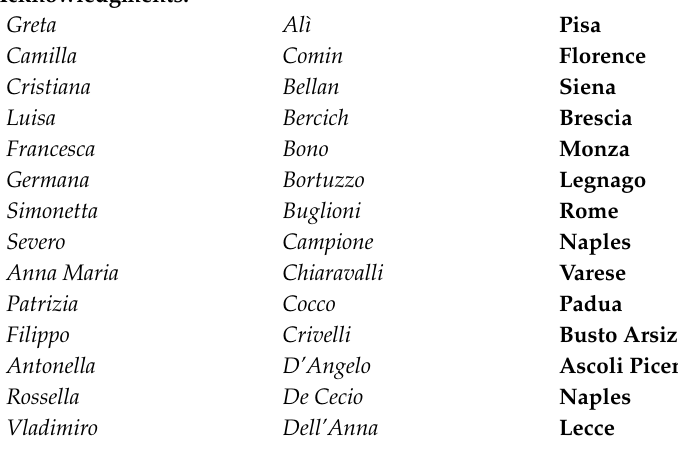
Table S1: Original PD-L1 evaluation, expert board consensus and prevalent scoring for every group; discrepancies between the original evaluation and the panel are highlighted in orange; participants errors in yellow. Table S2: Participant performances. In the columns, the cases of the study were grouped from negative (green, TPS < 1%) to strong positive (red, TPS ≥ 50%). In the first row, the gold standard results recorded by the board of experts were listed. In the following rows, for every pathologist who attended the meeting a progressive number and a colour of identification corresponding to the table were assigned. (ie.e R1: red table, participant number 1). Table S3: Performances by histotype. Table S4: Performances by